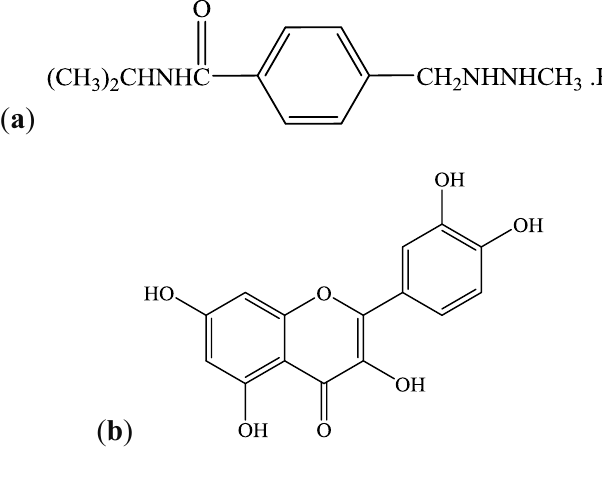
Figure 1. Chemical structures of Procarbazine ( N -isopropyl-a-(2-methyl-hydrazine)- p - toluamide hydrochloride) ( a ), and Quercetin (3,5,7,3′,4′-pentahydroxyflavone) ( b